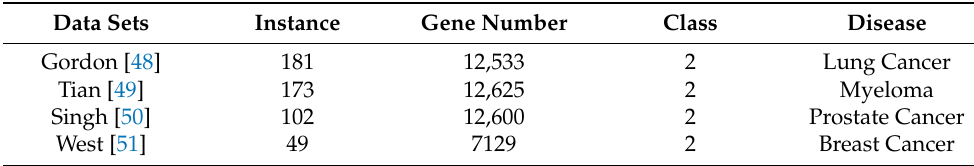
Table 1. Statistics of the microarray data sets.